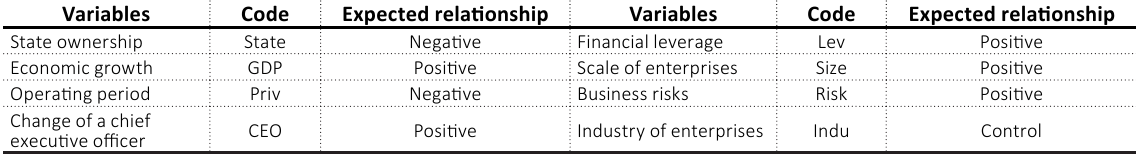
Table 2. Expected impact of financial criteria on financial